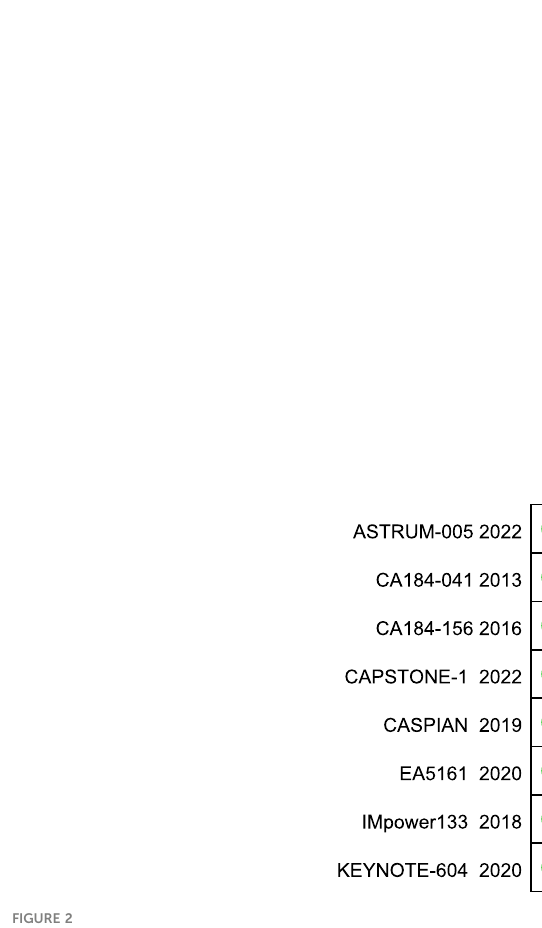
FIGURE 2 Methodological quality and risk of included